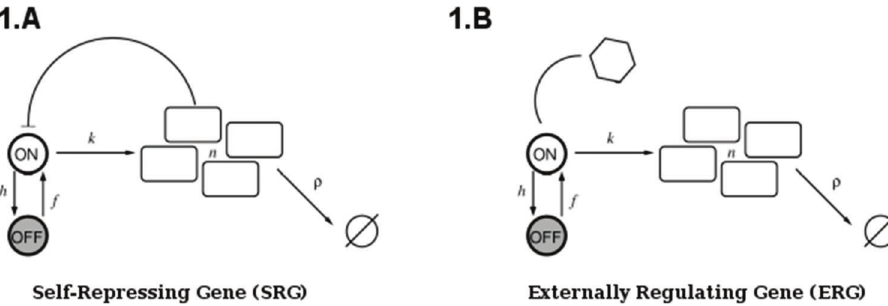
Figure 1 - ( A ) is a representation of a self-repressing gene, and ( B ) represents an externally regulated gene. The protein number is denoted by n, while its synthesis (degradation) rate is denoted by k ( r ). The ON to OFF and the OFF to ON state switching rates are indicated by h , and f ,